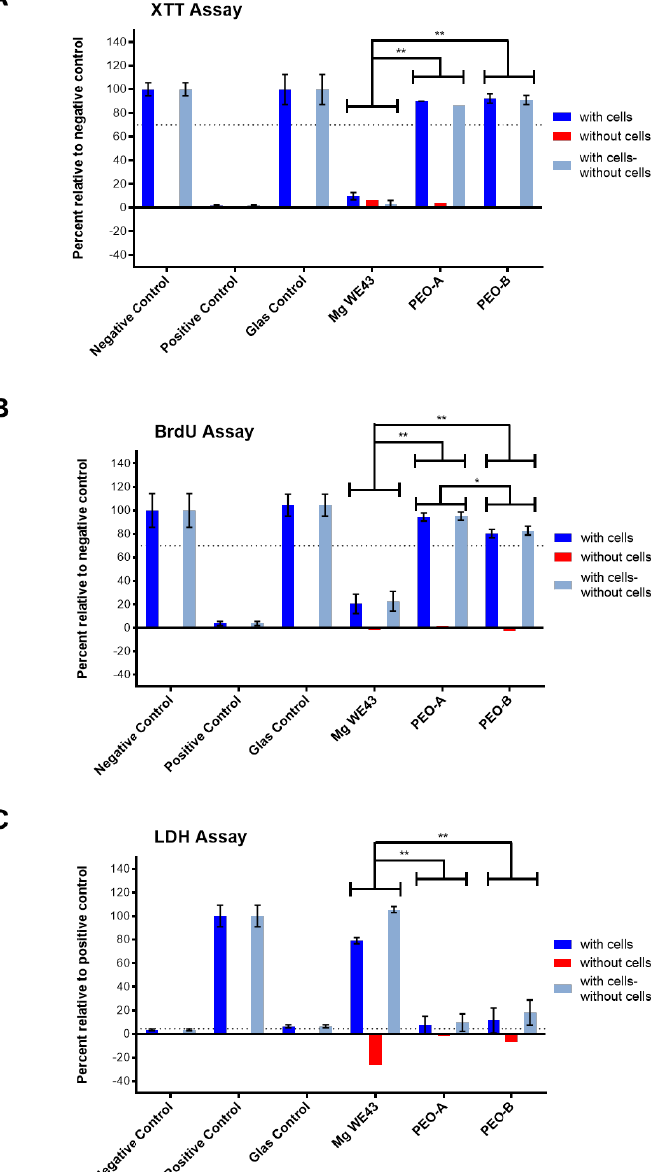
Figure 5. Cytocompatibility assessment of the Mg specimens WE43, PEO-B and PEO-A. ( A ) XTT assay indicating cell viability; ( B ) BrdU assay indicating cell proliferation; ( C ) LDH assay indicating the